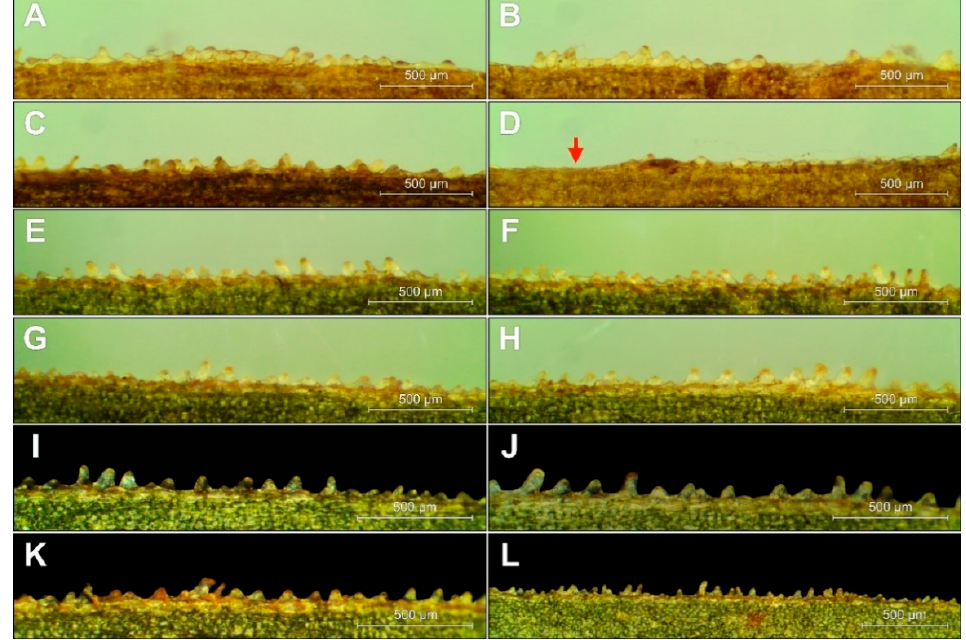
Figure 7. The arrangement of the conical cells (papillae) at E. greuteri . Origin of specimens: Romania, Semenic Mts. ( A – D ); Greece, Trikala, Pertouli, ( E – L ). The red arrow marks without papillae.